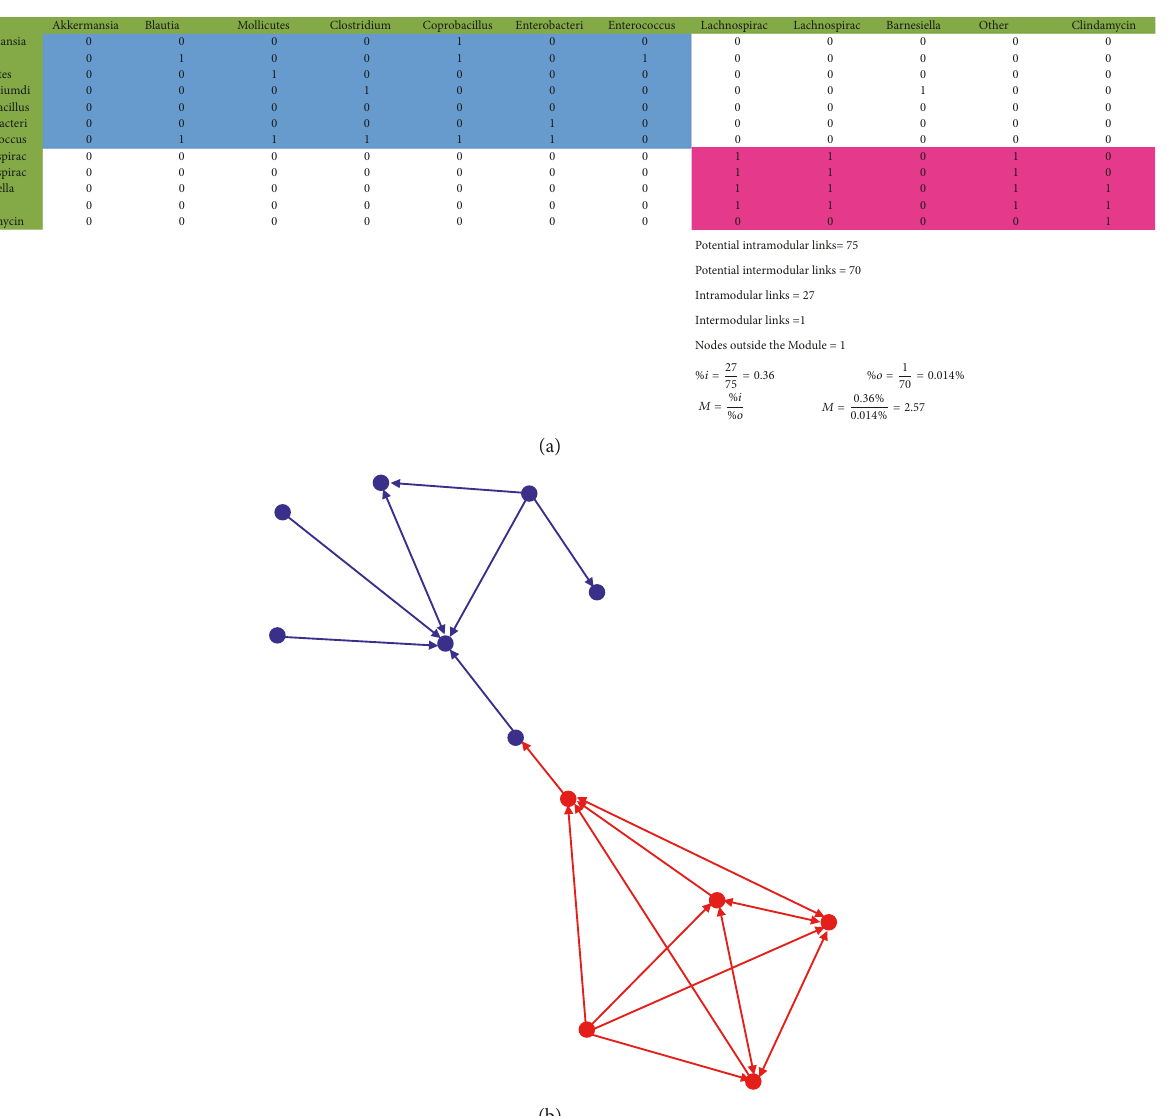
Figure 11: Adjacency matrix and modularity of a biological network related to infection treatment.